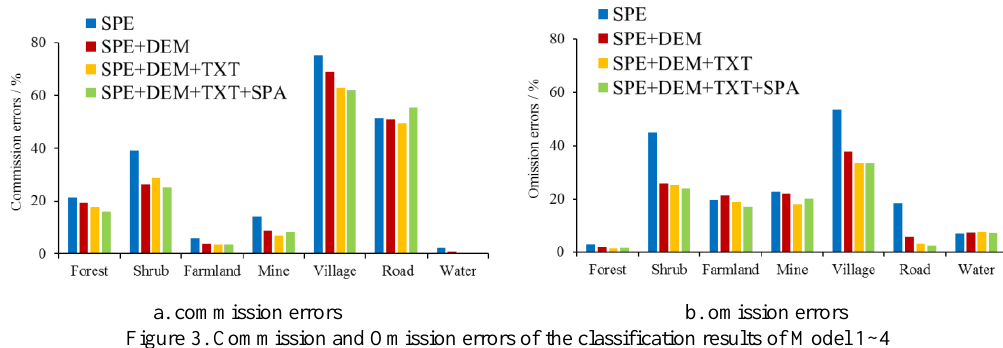
Figure 3. Commission and Omission errors of the classification results of Model 1~4